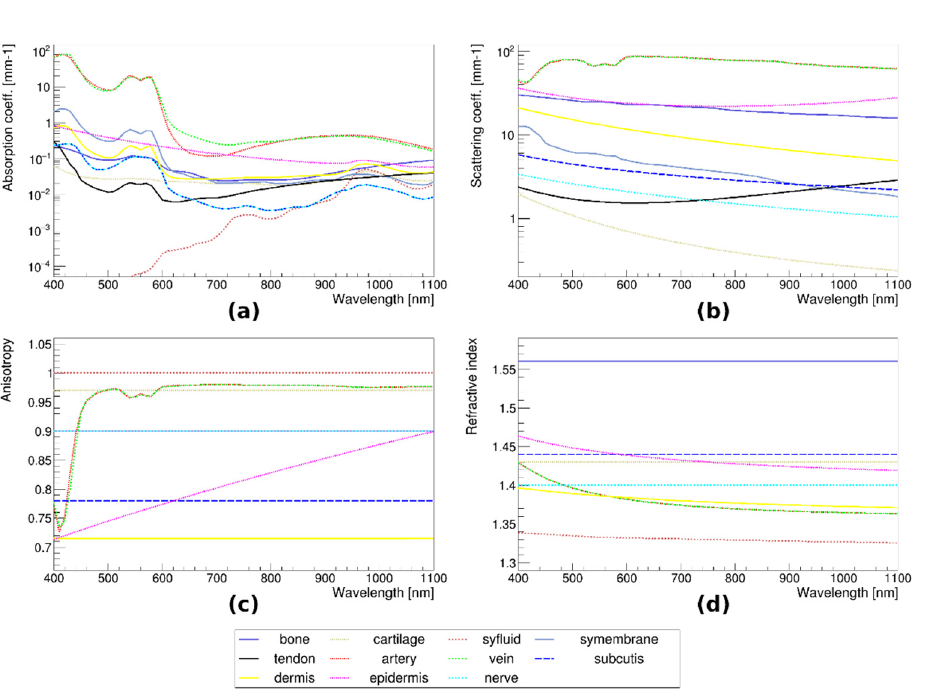
Figure A1. Wavelength dependence of the optical properties of unaffected tissues used in simulations: ( a ) absorption coefficient, ( b ) scattering coefficient, ( c ) anisotropy and ( d ) refractive index.